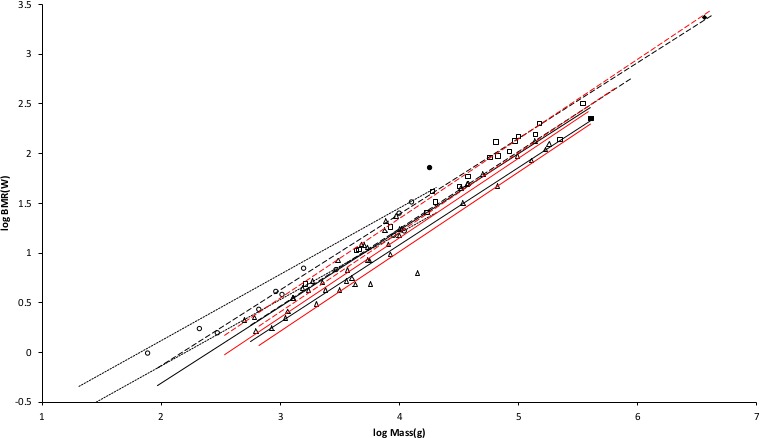
Log BMR as a function of log body mass for running/walking placental mammals.The Elephas maximus datum marked by a solid diamond is from Savage et al. (2004). All other data are species-averages from Kolokotrones et al. (2010). The solid, dashed, and dotted lines are MMLE sturdiness factor boundaries. The upper boundaries were generated with a sturdiness factor s = (3)0.5. The lower boundaries were generated with s = (3)−0.5. The black lines are for y = 2/3. The colored lines are for y = 0.8. The steeper sloping boundary lines are for Froude–Strouhal dynamic similarity. The shallower sloping boundary lines are for geometric similarity. Ruminant artiodactyl data are marked by open squares and \documentclass[12pt]{minimal}
\usepackage{amsmath}
\usepackage{wasysym}
\usepackage{amsfonts}
\usepackage{amssymb}
\usepackage{amsbsy}
\usepackage{upgreek}
\usepackage{mathrsfs}
\setlength{\oddsidemargin}{-69pt}
\begin{document}
}{}${R}_{M}^{2}$\end{document}RM2 is 0.9921 with respect to the dashed Froude–Strouhal black boundaries and \documentclass[12pt]{minimal}
\usepackage{amsmath}
\usepackage{wasysym}
\usepackage{amsfonts}
\usepackage{amssymb}
\usepackage{amsbsy}
\usepackage{upgreek}
\usepackage{mathrsfs}
\setlength{\oddsidemargin}{-69pt}
\begin{document}
}{}${R}_{M}^{2}$\end{document}RM2 is 0.9919 with respect to the dashed colored boundaries. Camelius dromedarius is a non-ruminant artiodactyl marked by a solid square. Carnivora less Mustelidae are marked with open triangles and \documentclass[12pt]{minimal}
\usepackage{amsmath}
\usepackage{wasysym}
\usepackage{amsfonts}
\usepackage{amssymb}
\usepackage{amsbsy}
\usepackage{upgreek}
\usepackage{mathrsfs}
\setlength{\oddsidemargin}{-69pt}
\begin{document}
}{}${R}_{M}^{2}$\end{document}RM2 is 0.9752 with respect to the solid Froude–Strouhal black boundaries and \documentclass[12pt]{minimal}
\usepackage{amsmath}
\usepackage{wasysym}
\usepackage{amsfonts}
\usepackage{amssymb}
\usepackage{amsbsy}
\usepackage{upgreek}
\usepackage{mathrsfs}
\setlength{\oddsidemargin}{-69pt}
\begin{document}
}{}${R}_{M}^{2}$\end{document}RM2 is 0.9655 with respect to the solid colored boundaries. Mustelids except Enhydra are marked with open circles and \documentclass[12pt]{minimal}
\usepackage{amsmath}
\usepackage{wasysym}
\usepackage{amsfonts}
\usepackage{amssymb}
\usepackage{amsbsy}
\usepackage{upgreek}
\usepackage{mathrsfs}
\setlength{\oddsidemargin}{-69pt}
\begin{document}
}{}${R}_{M}^{2}$\end{document}RM2 is 0.9999 with respect to the dotted geometric black boundaries. Enhydra lutris is an ocean going swimming mustelid marked by a solid circle.